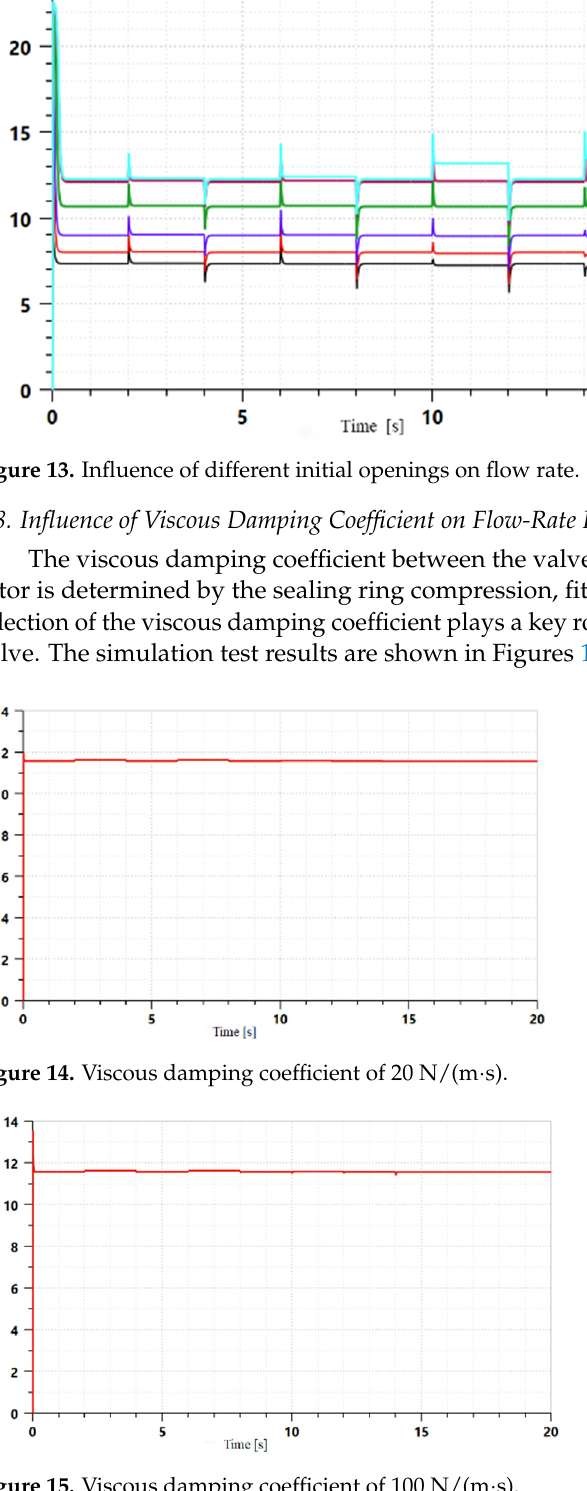
Figure 16. Viscous damping coefficient of 1000 N/(m·s). Figure 17. Viscous damping coefficient of 2000 N/(m·s).